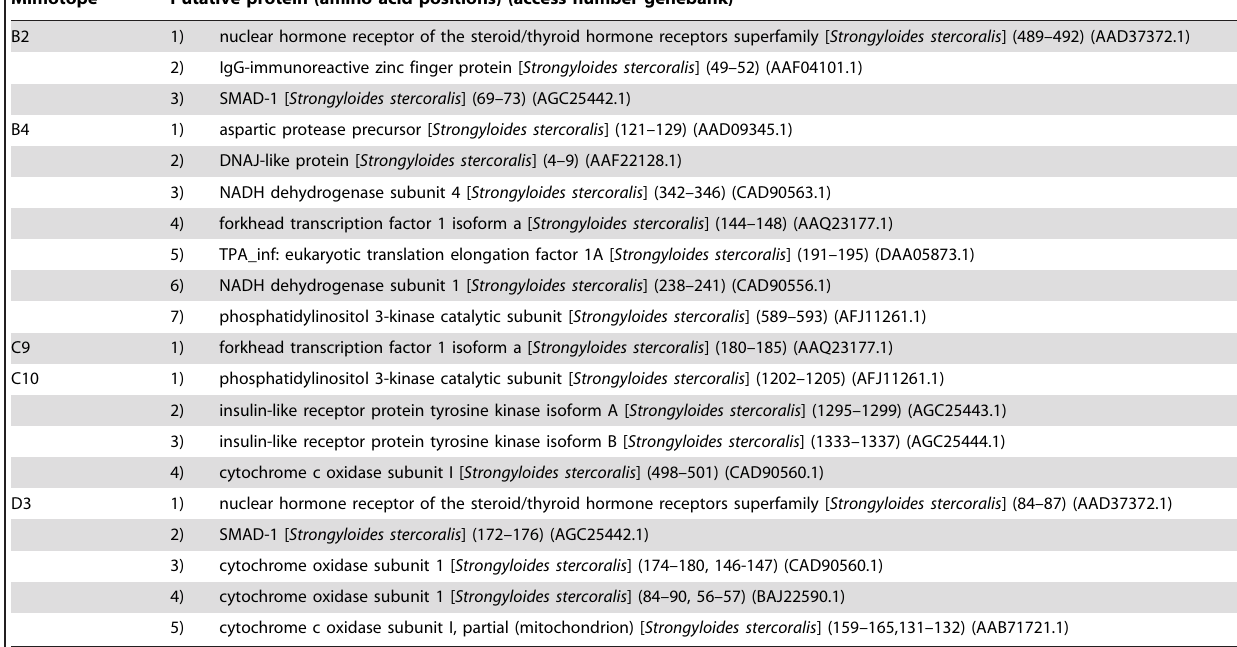
Mimotope Putative protein (amino acid positions) (access number genebank)